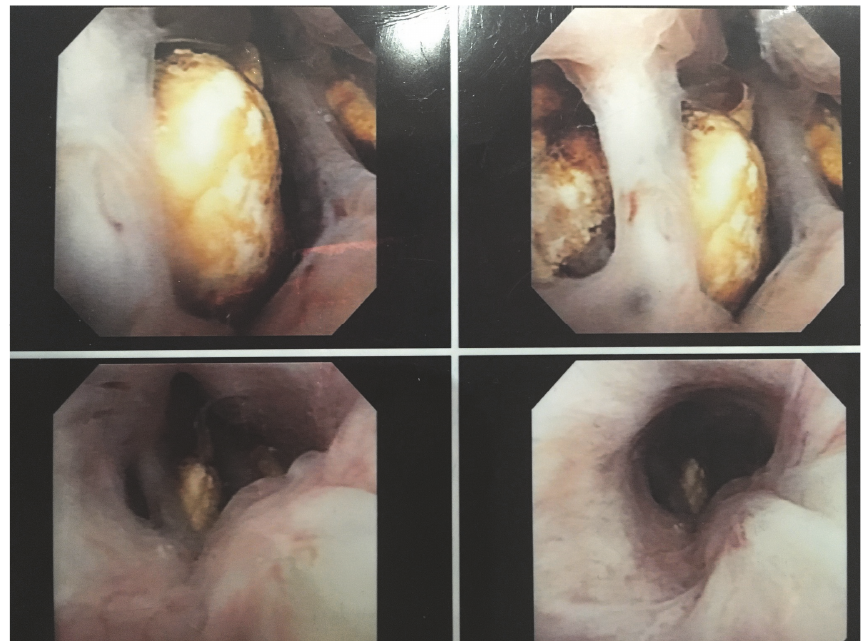
Figure 2: Axial view of CT abdomen and pelvis noting a large burden of prostate stones.